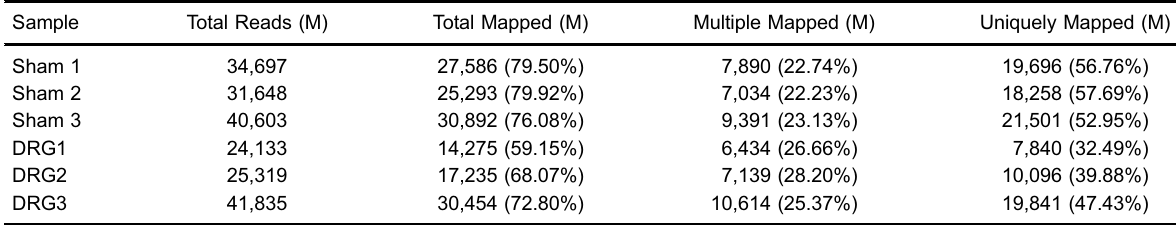
Table 2. Mapping results of transcriptome to referenced genome.